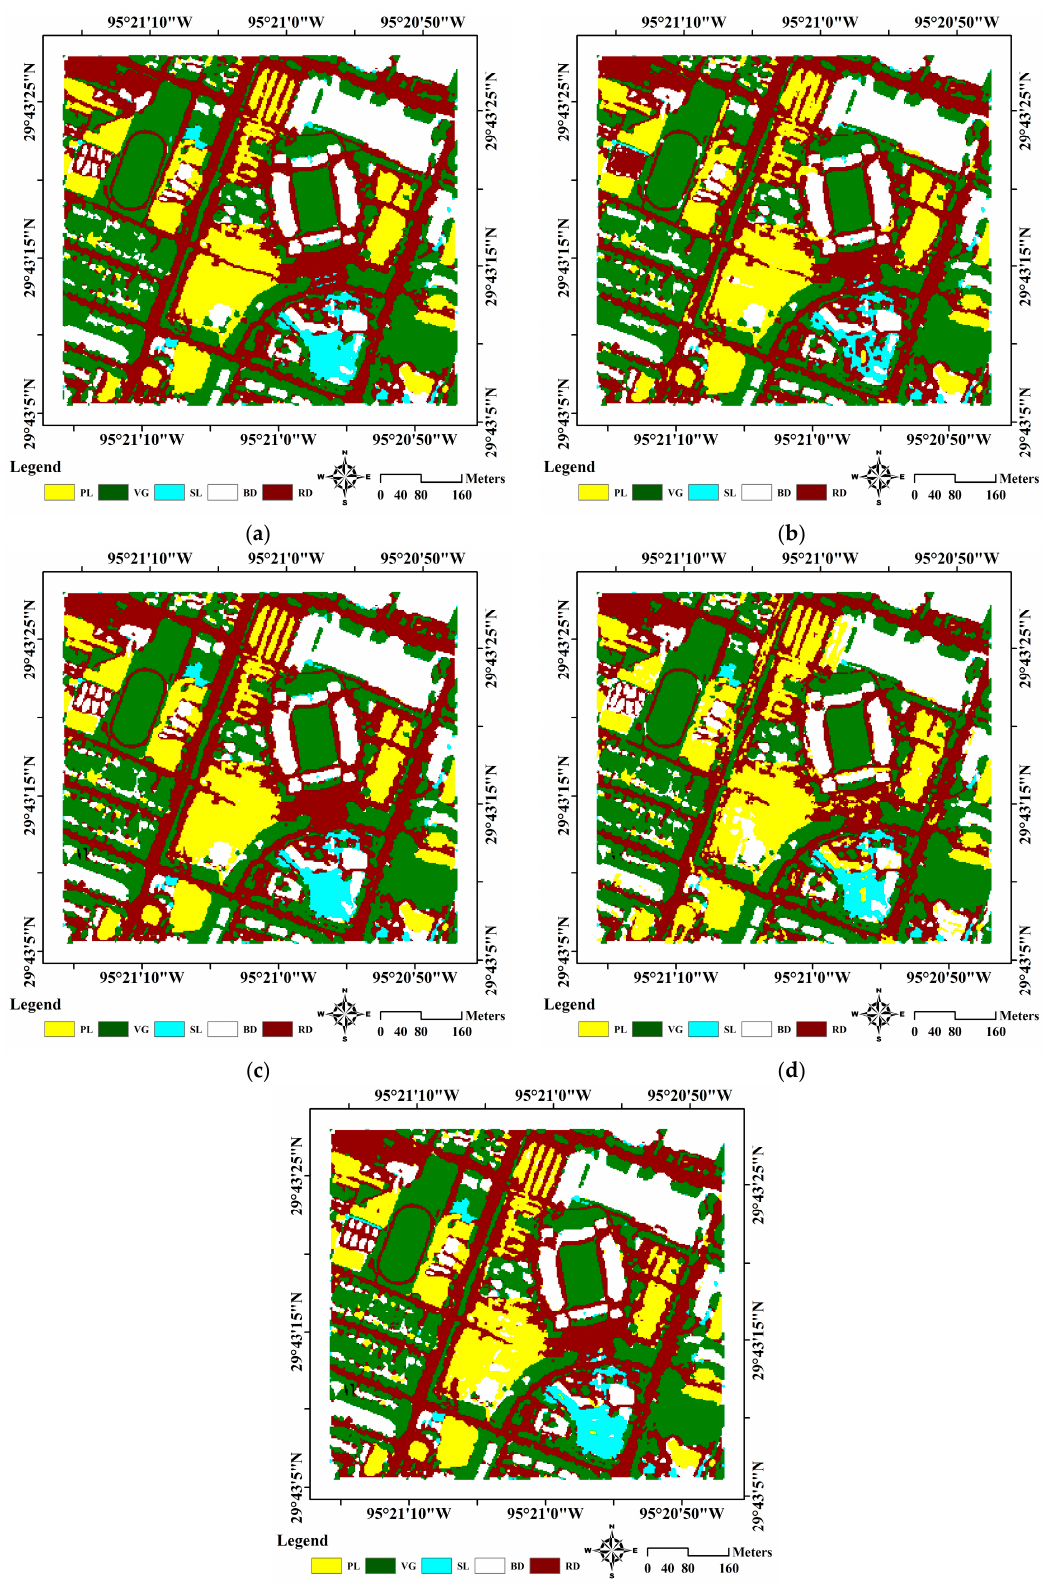
Figure 14. The results of classification in the third test area by: ( a ) the proposed method; ( b ) CL-DT; ( c ) SAE; ( d ) CART; and ( e ) RFs.